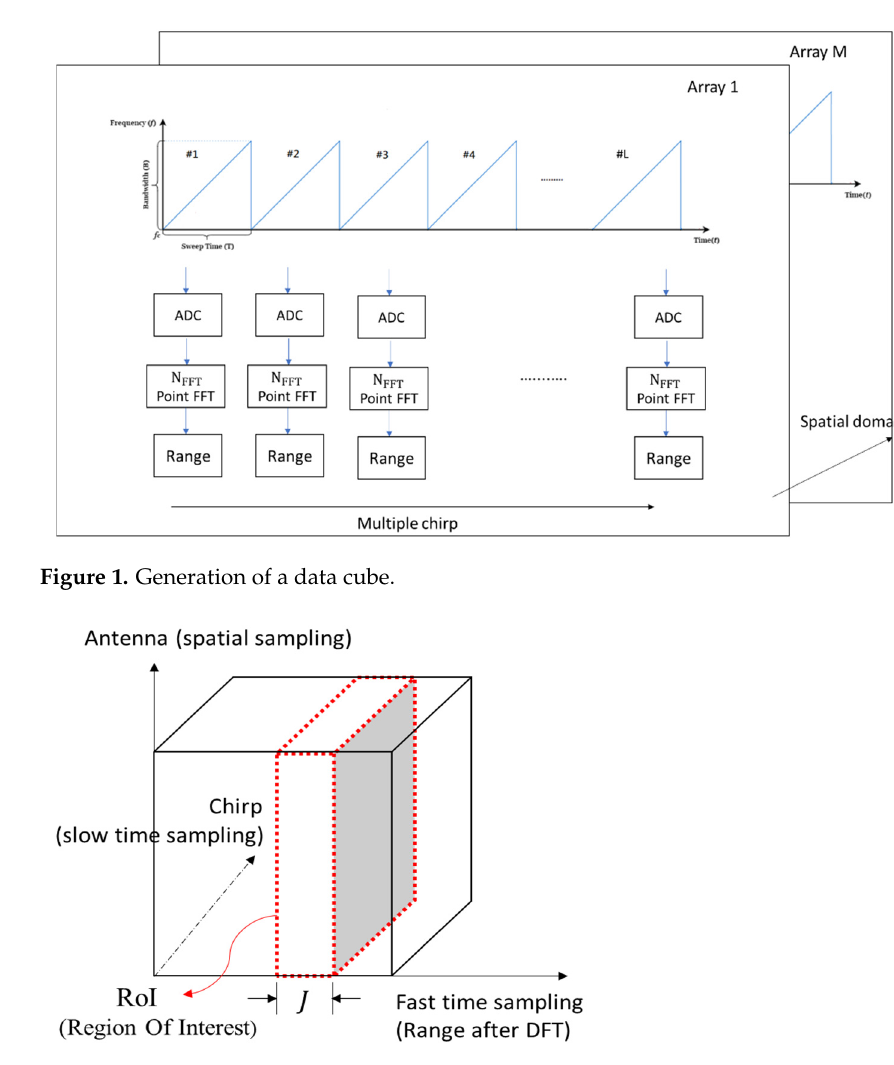
Figure 2. RoI selection in a data cube.